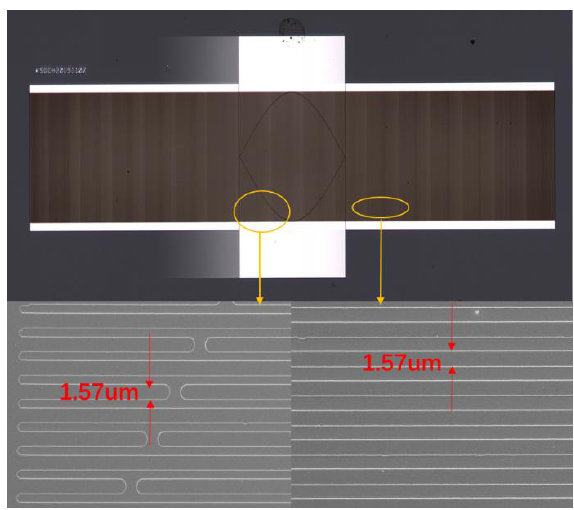
Figure 13. Optical picture of the proposed sensing devices.